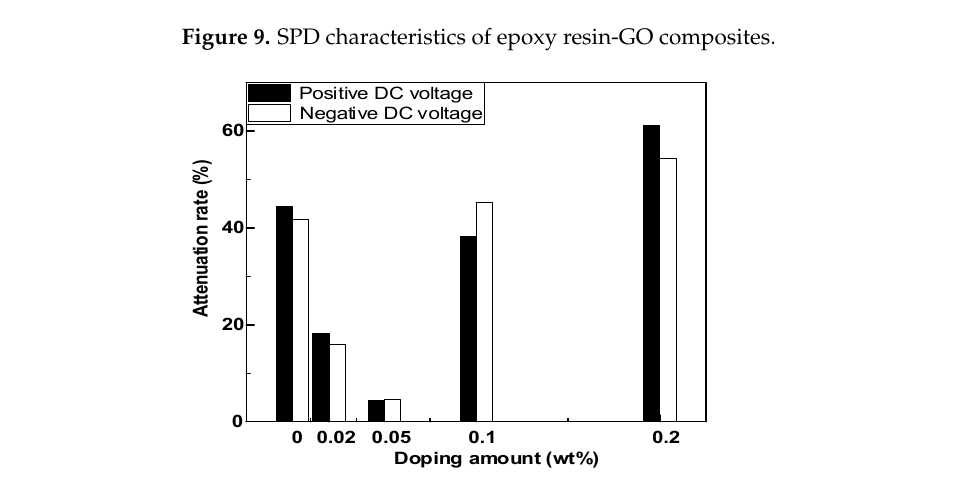
Figure 10. The 20 min surface potential attenuation rate of epoxy resin–GO composites. Figure 11a,b show the positive and negative trap distribution characteristics of epoxy resin–GO composites. With an increase in the nano GO doping ratio, the electron trap energy level and density and hole trap energy level and density showed an upward trend,